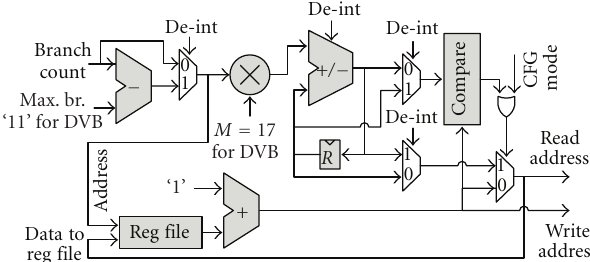
Figure 15: HW for RAM read/write address generation for convolutional